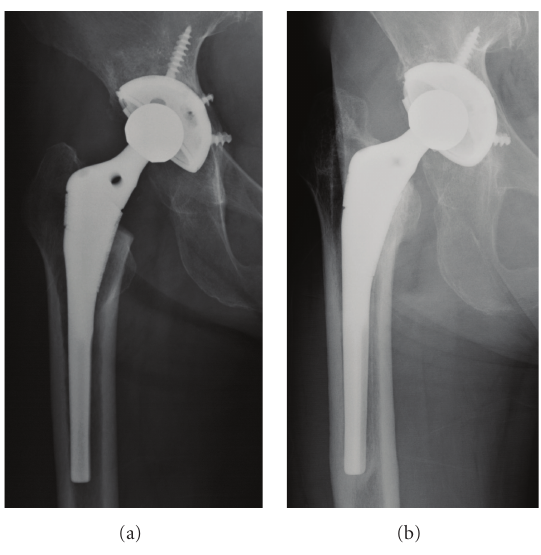
Figure 4: The right hip of 45-year-old female who had received bilateral THA for rapidly destructive coxarthrosis. (a) The post- operative AP radiograph. The stem had been undersized, and metaphyseal fit had been poor. (b) The AP radiograph at 6.1 years after THA. The stem showed subsidence and